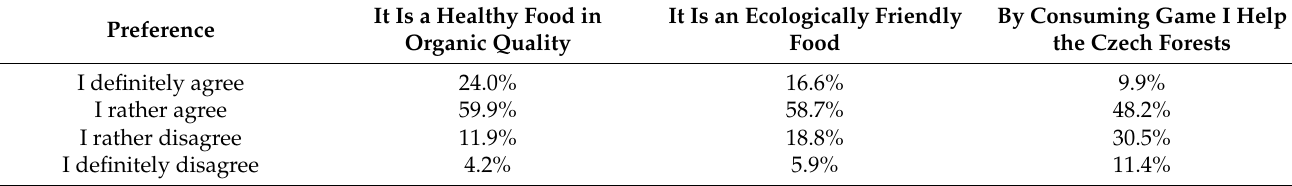
Table 7. Which of the following statements about game do you agree with ( n =